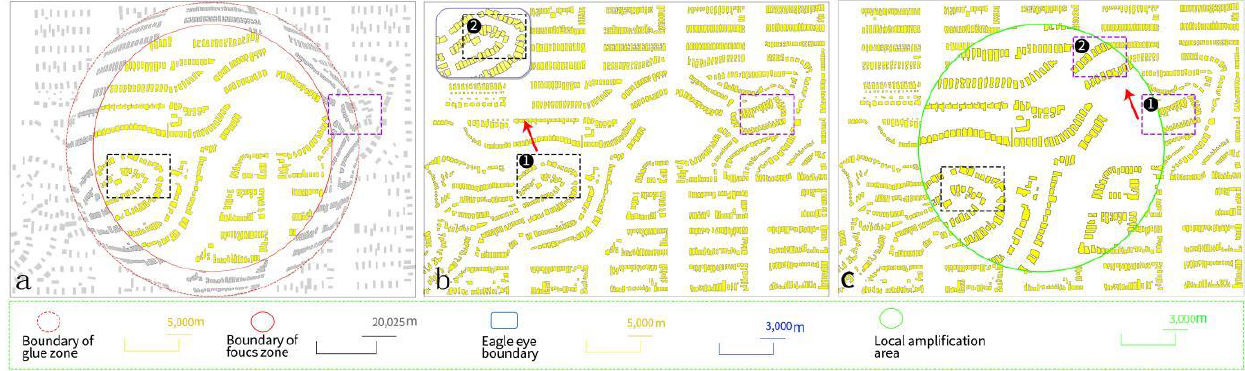
Figure 18. Comparison with traditional methods. ( a ) The result of variable-scale map. ( b ) The result of eagle eye map. ( c ) The result of roaming Map.